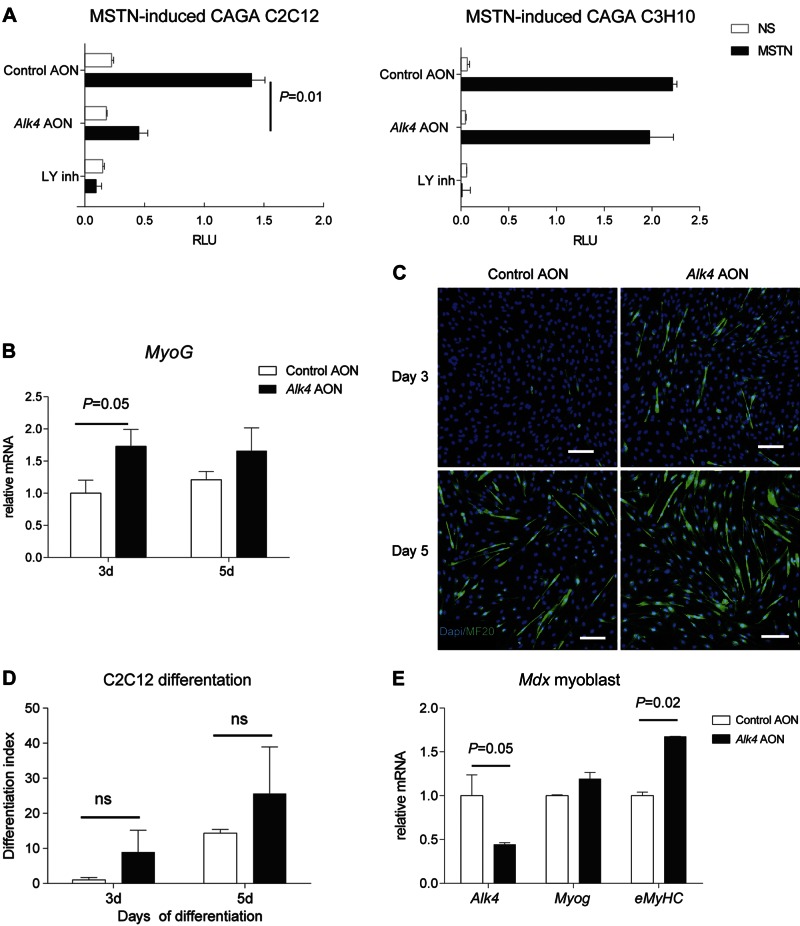
Alk4 AON blocks MSTN signaling and enhances myoblast differentiation. A) Alk4 AON (200 nM) specifically repressed MSTN-induced Smad3-dependent (CAGA)12-luciferase activity in C2C12 murine myoblasts, whereas Alk4 AON did not inhibit MSTN activity in C3H10T1/2 mesenchymal stem cells. LY364947 inhibitor (LY inh; 10 μM) was added to the cells as a positive control for blockage of MSTN activity. The cells were stimulated with MSTN or nonstimulated (NS). Firefly luciferase activity of (CAGA)12-luciferase constructs were normalized to Renilla luciferase activity of cotransfected CMV-renilla constructs. The normalized values are in relative light units (RLU). B) qPCR was performed to measure the Myog expression of C2C12 cells transfected with Alk4 or control AON (100 nM) at 3 and 5 d after initiation of myogenic differentiation. Alk4 AON increased the Myog expression. C) Immunofluorescence images of C2C12 cells transfected with Alk4 or control AON (100 nM) at 3 and 5 d after initiation of myogenic differentiation. Cells were stained with myosin (differentiated myotubes, green) and DAPI (nuclear, blue). Scale bars, 10 µm. D) The differentiation index was calculated as the percentage of the total number of myogenic cells that were myosin+. E) AON targeting exon 6 of Alk4 (Alk4 AON) and scrambled control AON were transfected at 50 nM concentration into mdx myoblasts. RNA was isolated after 48 h. Real-time qPCR was performed to measure full-length Alk4 transcript down-regulation and myogenic gene expression. The data are presented as the average of the results of 3 independent experiments normalized to Gapdh and are shown relative to control AON samples. Error bars, sd.